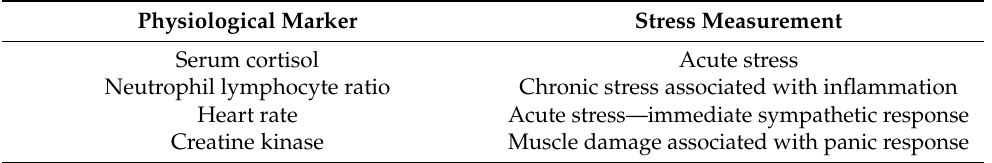
Table 4. List of selected physiological markers and what specific component of a stress response each evaluates. Physiological Marker Stress Measurement Serum cortisol Acute stress Neutrophil lymphocyte ratio Chronic stress associated with inflammation Heart rate Acute stress—immediate sympathetic response Creatine kinase Muscle damage associated with panic